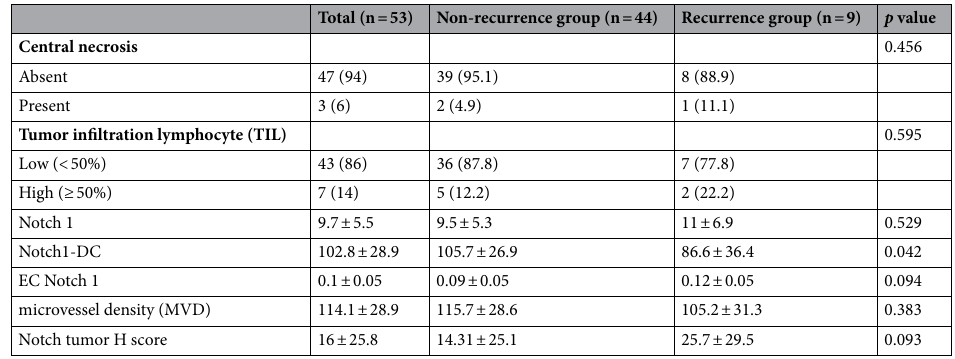
Table 1. Clinico-pathologic characteristic of patients. † Based on AJCC 7th, including yp stage. †† Nottingham histologic grade.